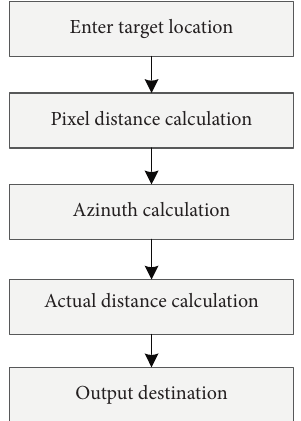
Figure 9: Target positioning